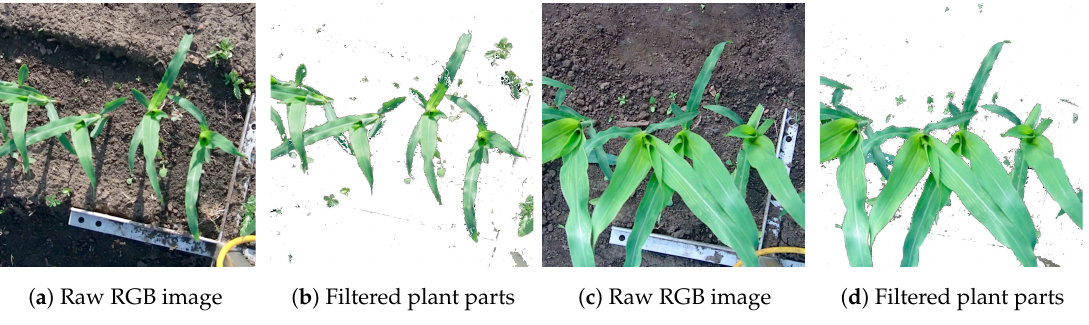
Figure 12. ( a – d ) Extraction of the leaf area using a green filtering algorithm in MATLAB compared to the raw images. ( a , c ) show exemplary raw RGB images as input data and the resulting green filtered masks in ( b , d